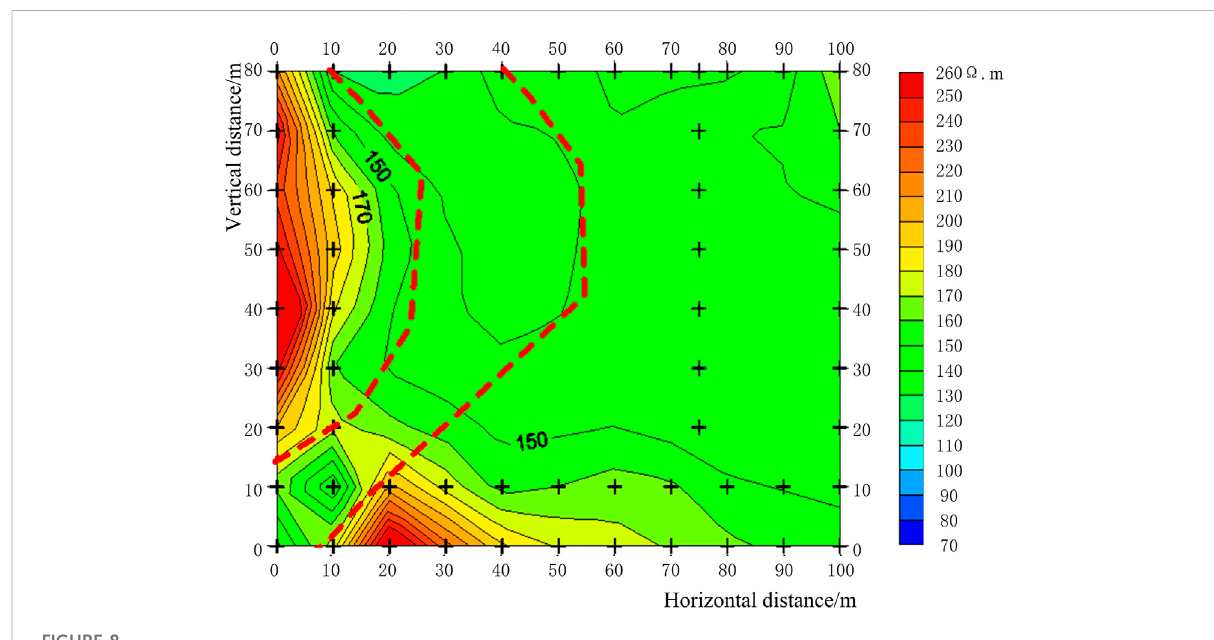
FIGURE 8 Horizontal pro fi le of apparent resistivity at a depth of -160 m.